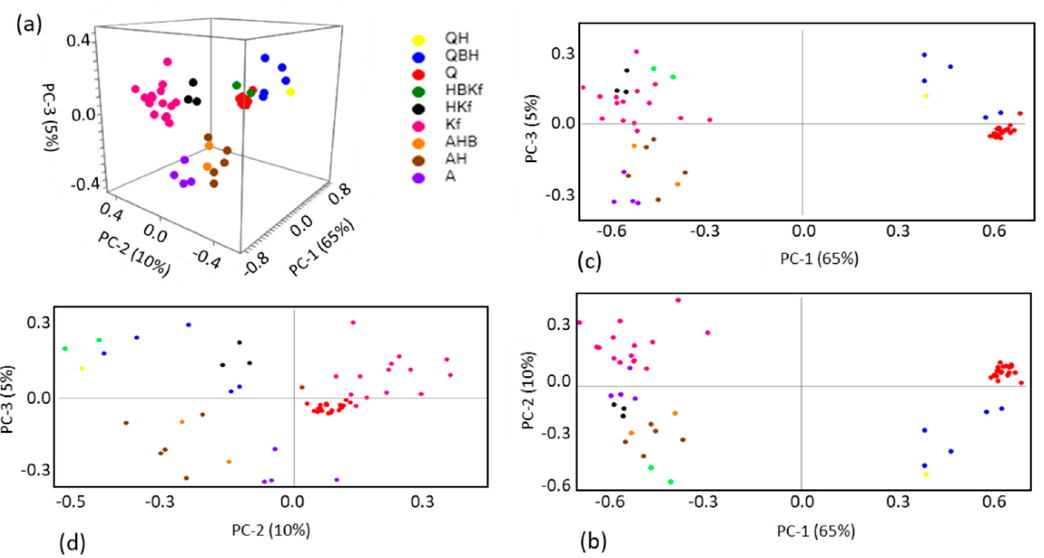
Figure 4. PCA scores plots ( ( a ) PC-3 vs. PC-2 vs. PC-1, ( b ) PC-2 vs. PC-1, ( c ) PC-3 vs. PC-1, ( d ) PC-3 vs. PC-2) resulting from the analysis of the Raman spectra of the core section of the studied fulgurite. Q: quartz; B: barite; H: hematite; A: albite; Kf: K-fedspar (microcline).